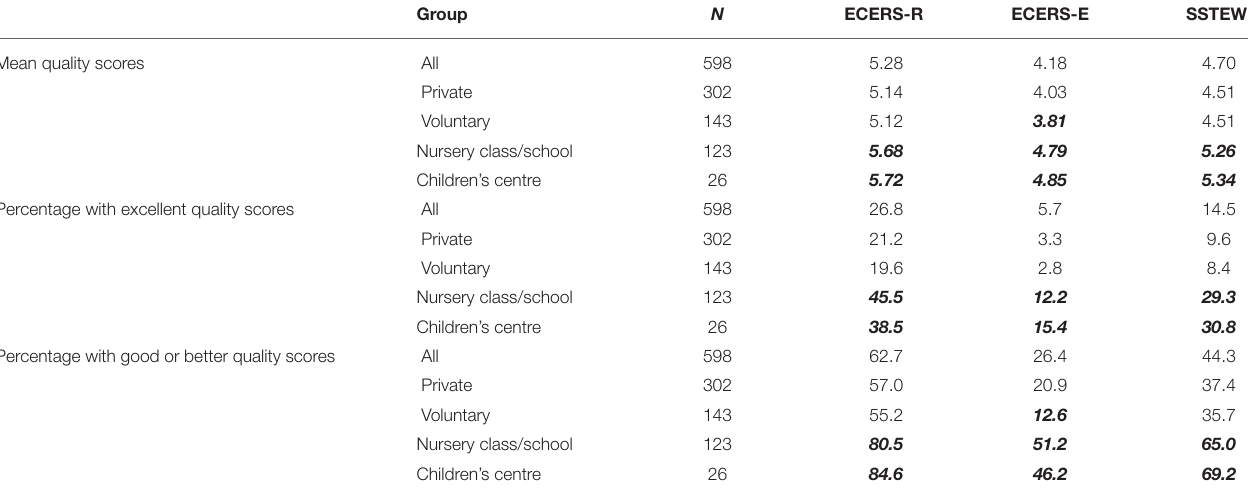
TABLE 3 | ECEC Settings quality scores. Group N ECERS-R ECERS-E SSTEW Mean quality